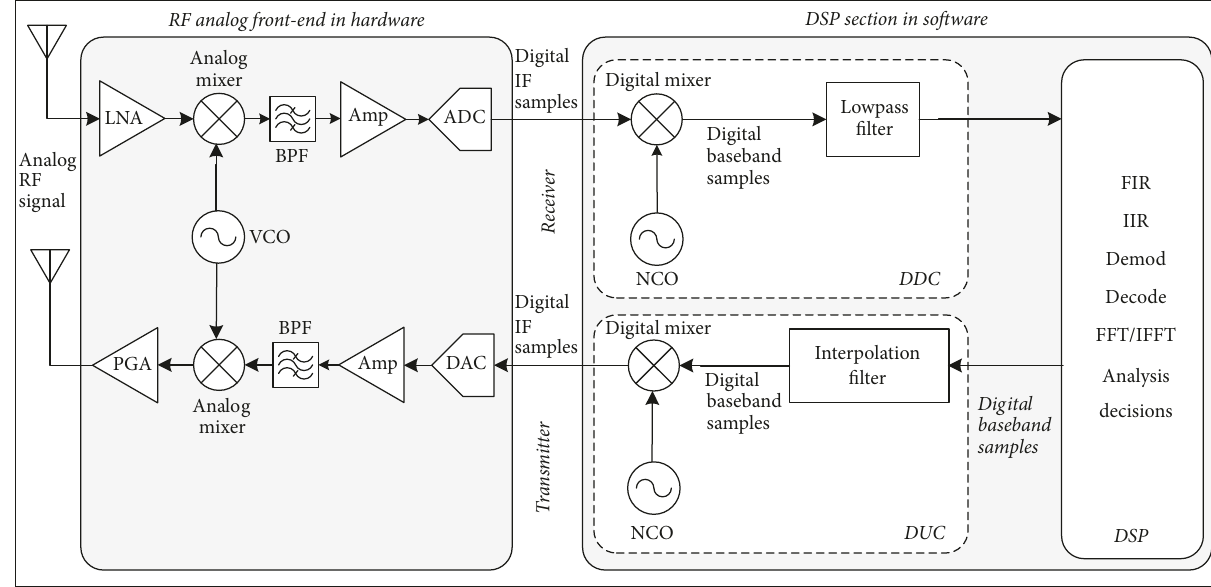
Figure 1: Radio transceiver